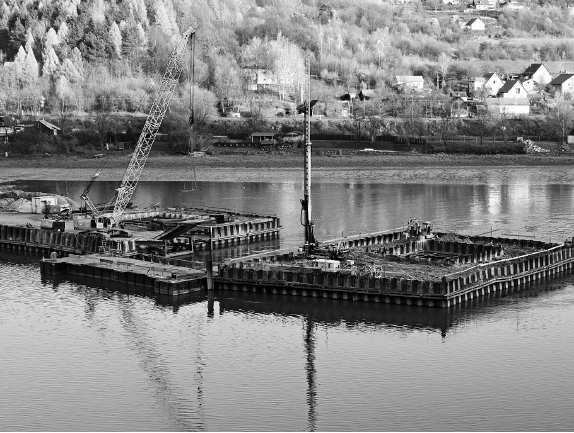
Figure 5. Implementation of jet